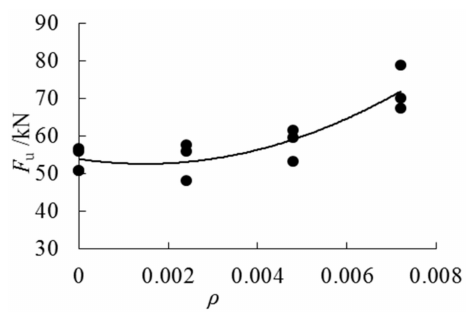
Figure 8. Load–deflection curve.